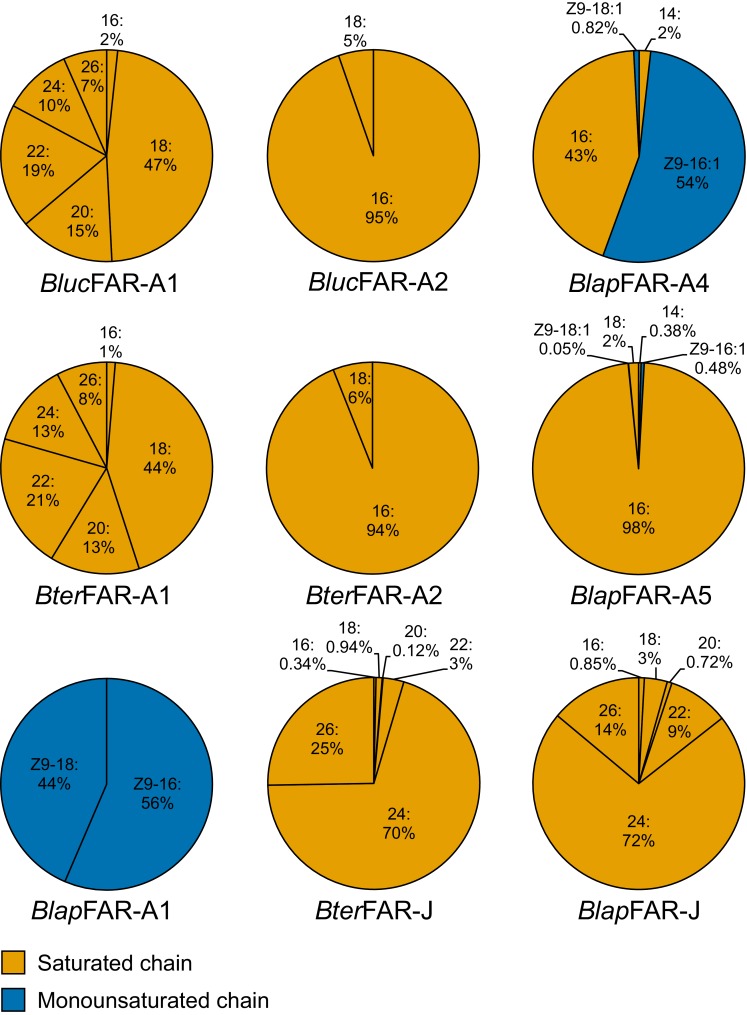
Relative amounts of fatty alcohols produced in bumble bee FAR-expressing yeasts.The graphs show relative weight percentages of individual fatty alcohols in the total fatty alcohol mixtures produced by FAR-expressing yeast cells.